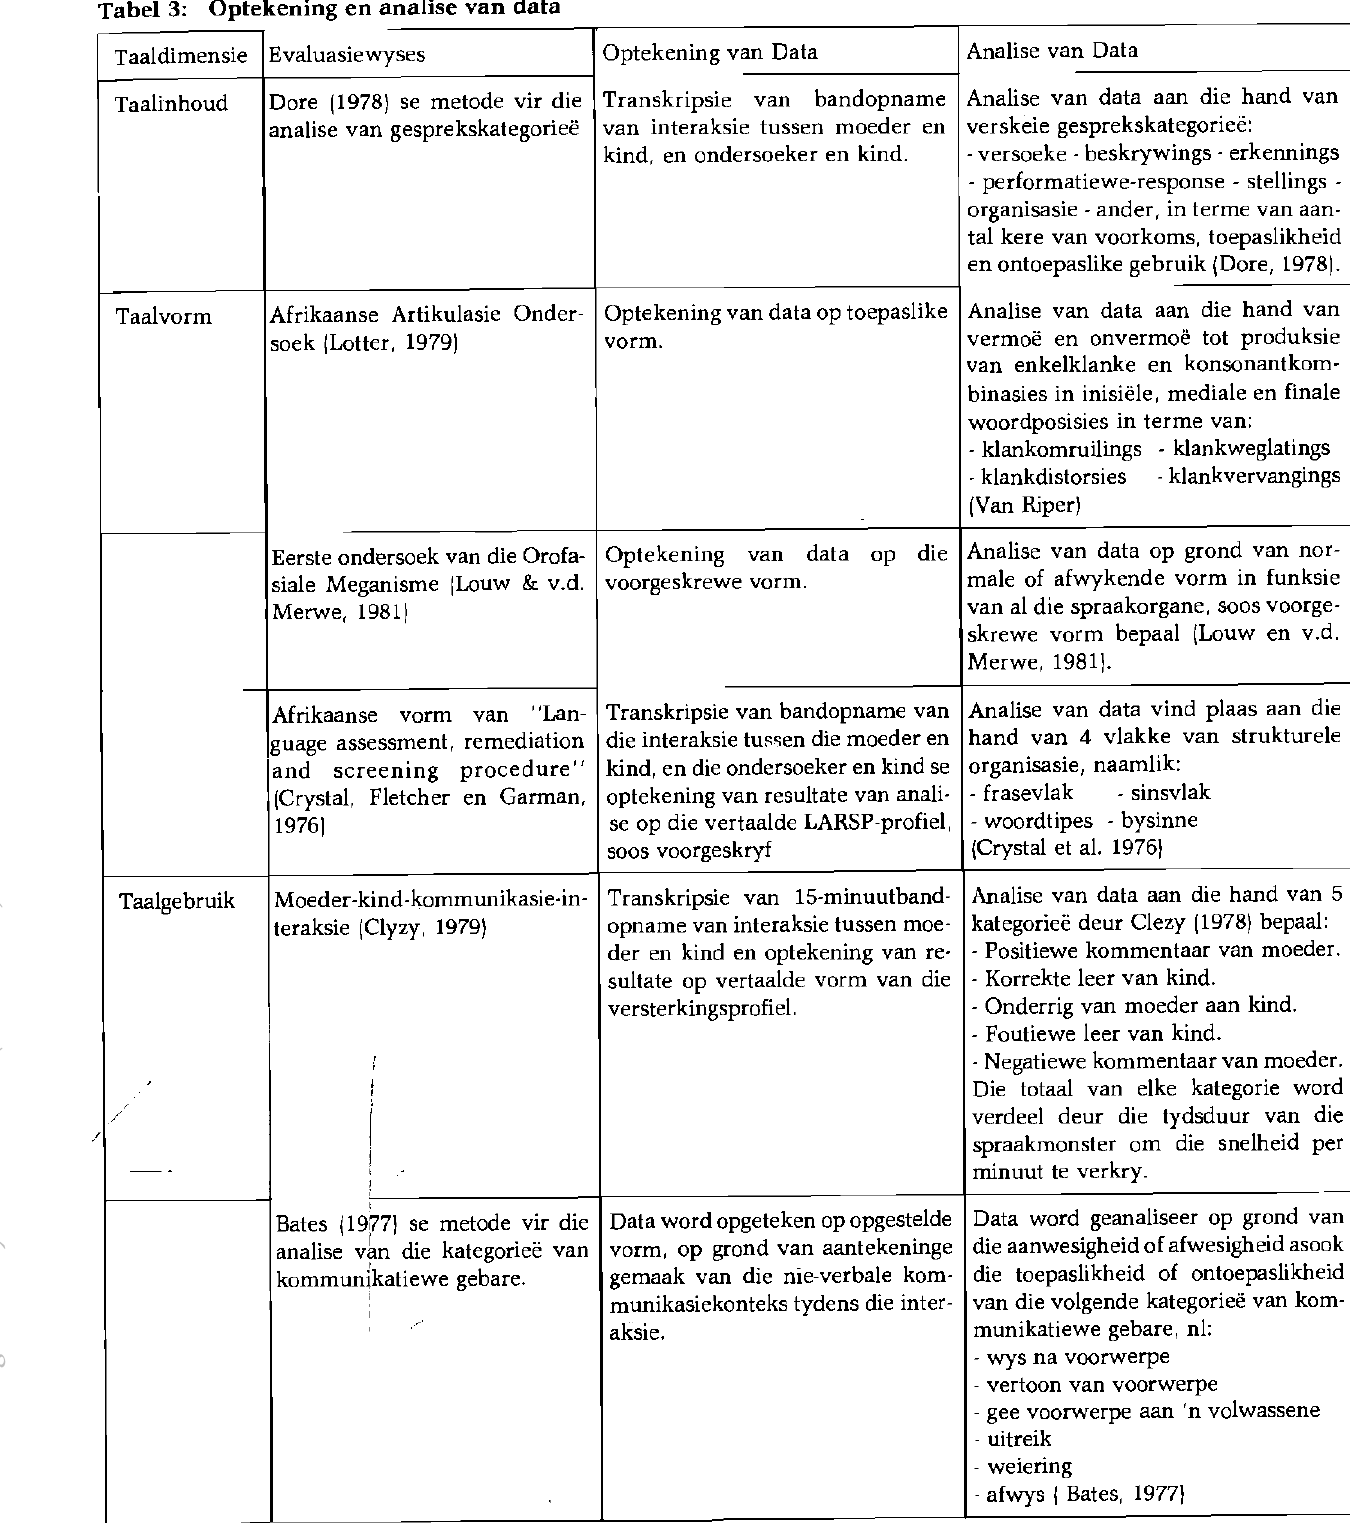
Tabel 3: Optekening en analise van data Taaldimensie Evaluasiewyses